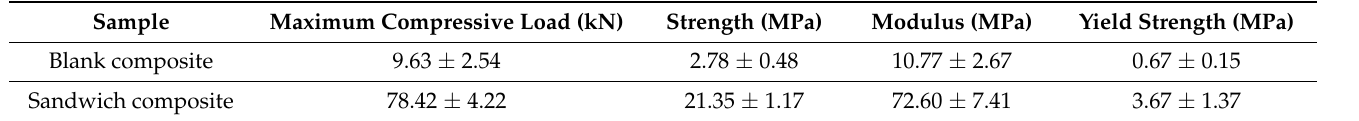
Figure 9. Illustration of compressing molding via hot pressing mode [87]. Reproduced with permis- sion from Elsevier. Table 1. Compression properties of blank composite and sandwich composite [87]. Reproduced with permission from Elsevier.